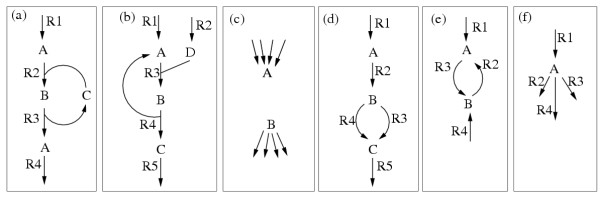
Small example networks illustrating redundancies. For explanations see text.